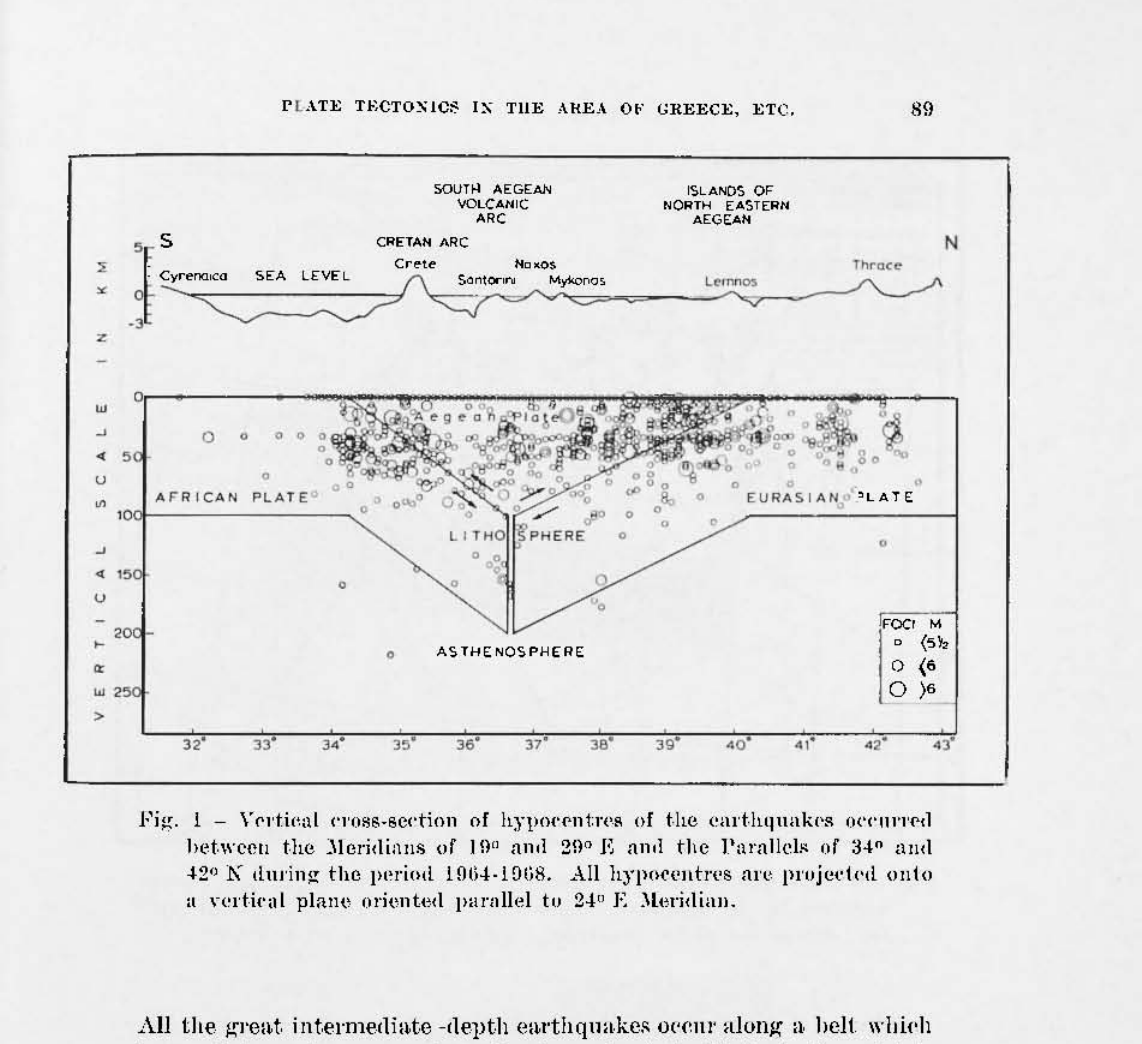
Fig-. l - \,pl'ti('al n08s-sc('tion oI hYP(){'pntn'~ oI tlte earthqllakp~ 0('('111'1'p<1 het.wcctl t.hc )lcri(linlls or l n" a11<1 2no E a11<1 thc l'arallel.~ or 34°